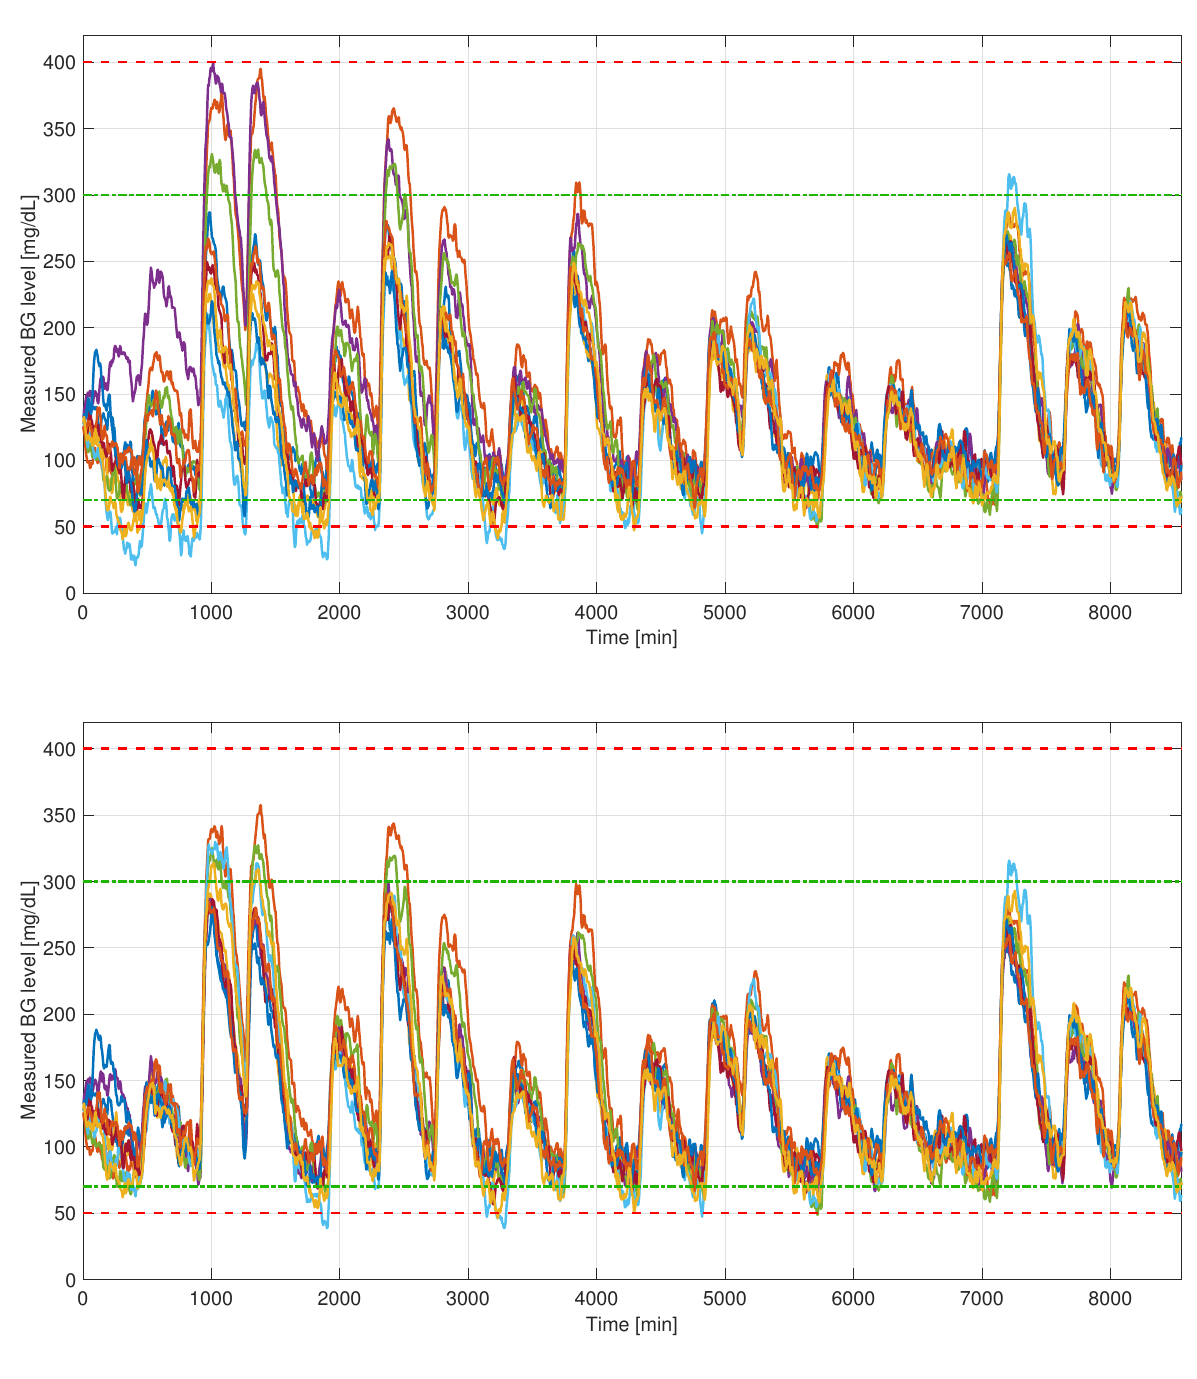
Figure 4. Measured and noise-corrupted BG levels. The top figure shows the slow adaptation case, while the bottom corresponds to the fast. The red dashed line indicates a tolerable region of BG level, while the green dash-dotted line shows the optimal